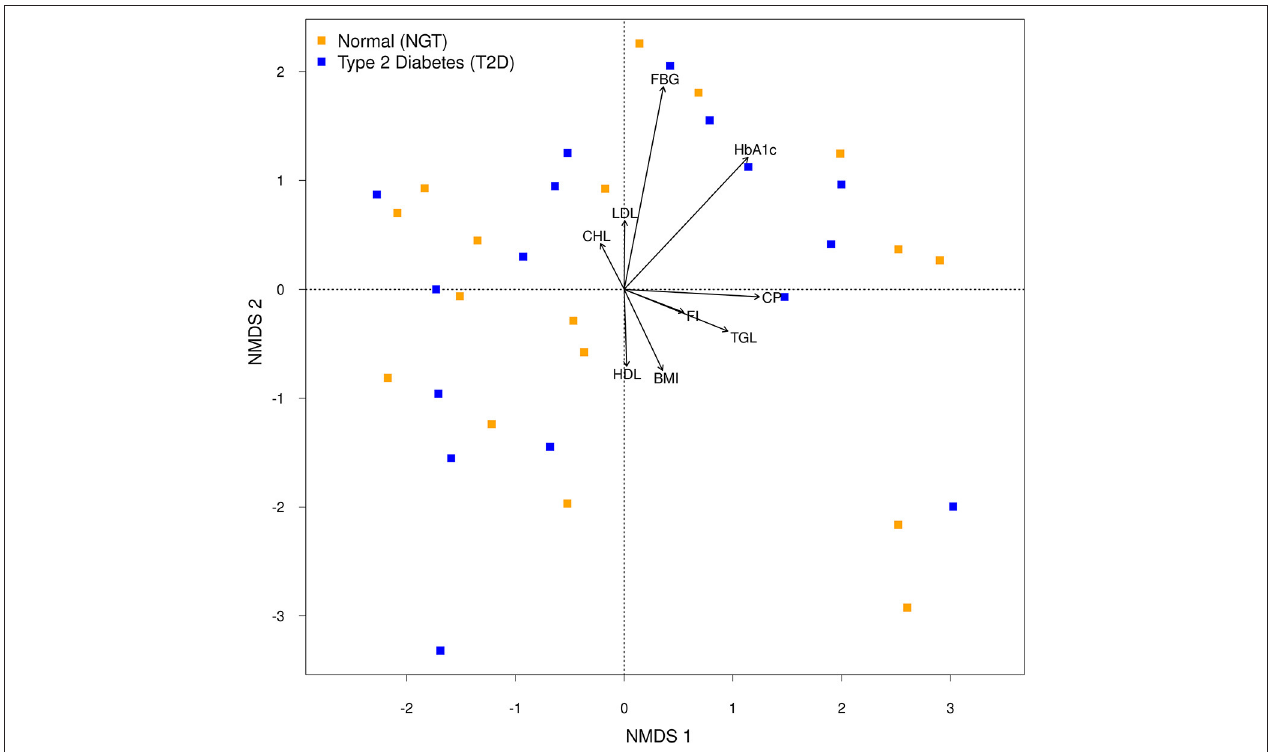
FIGURE 4 | Non-metric multidimensional scaling (NMDS) plot of the bacterial communities of each group. Arrows of the NMDS plot indicate envfit correlations of bacterial community composition with physiological